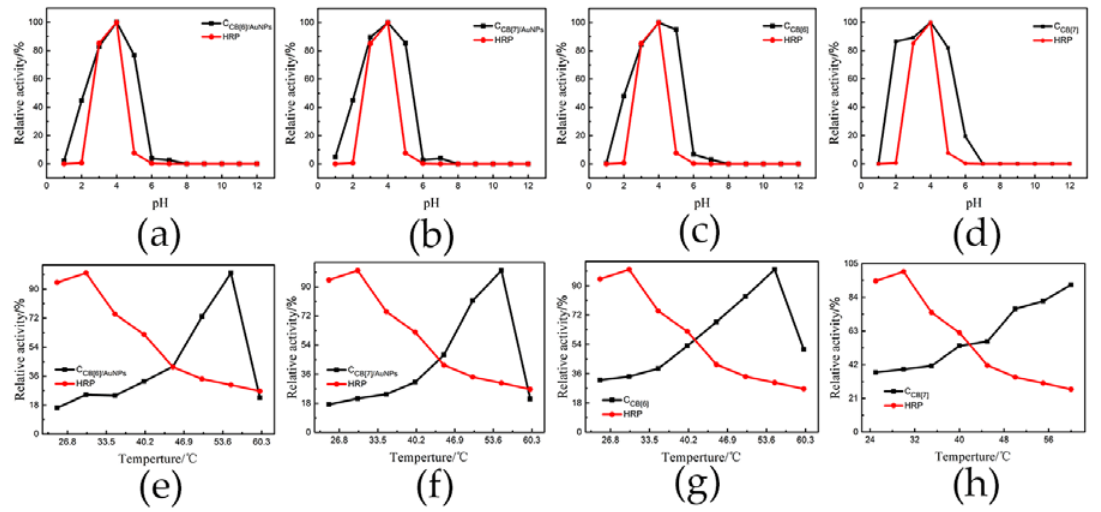
Figure 5. pH dependent response curves of different materials in this work and HRP: ( a ) C CB[6]/AuNPs ; ( b ) C CB[7]/AuNPs ; ( c ) C CB[6] ; ( d ) C CB[7] . Temperature dependent response curves of different materials in this work and HRP: ( e ) C CB[6]/AuNPs ; ( f ) C CB[7]/AuNPs ; ( g ) C CB[6] ; ( h ) C CB[7] .